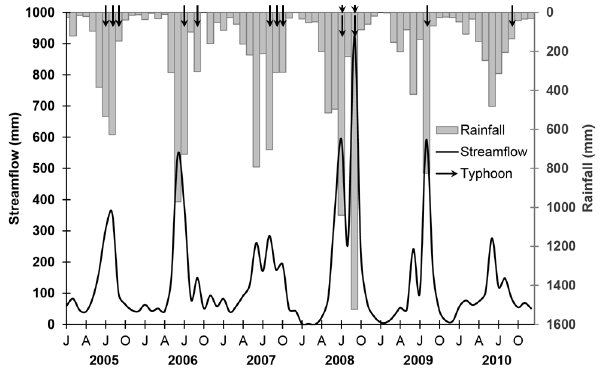
Fig. 2. The monthly rainfall and streamflow between 2005 and Fig. 2. 2010. Each arrow indicates the occurrence of a typhoon.